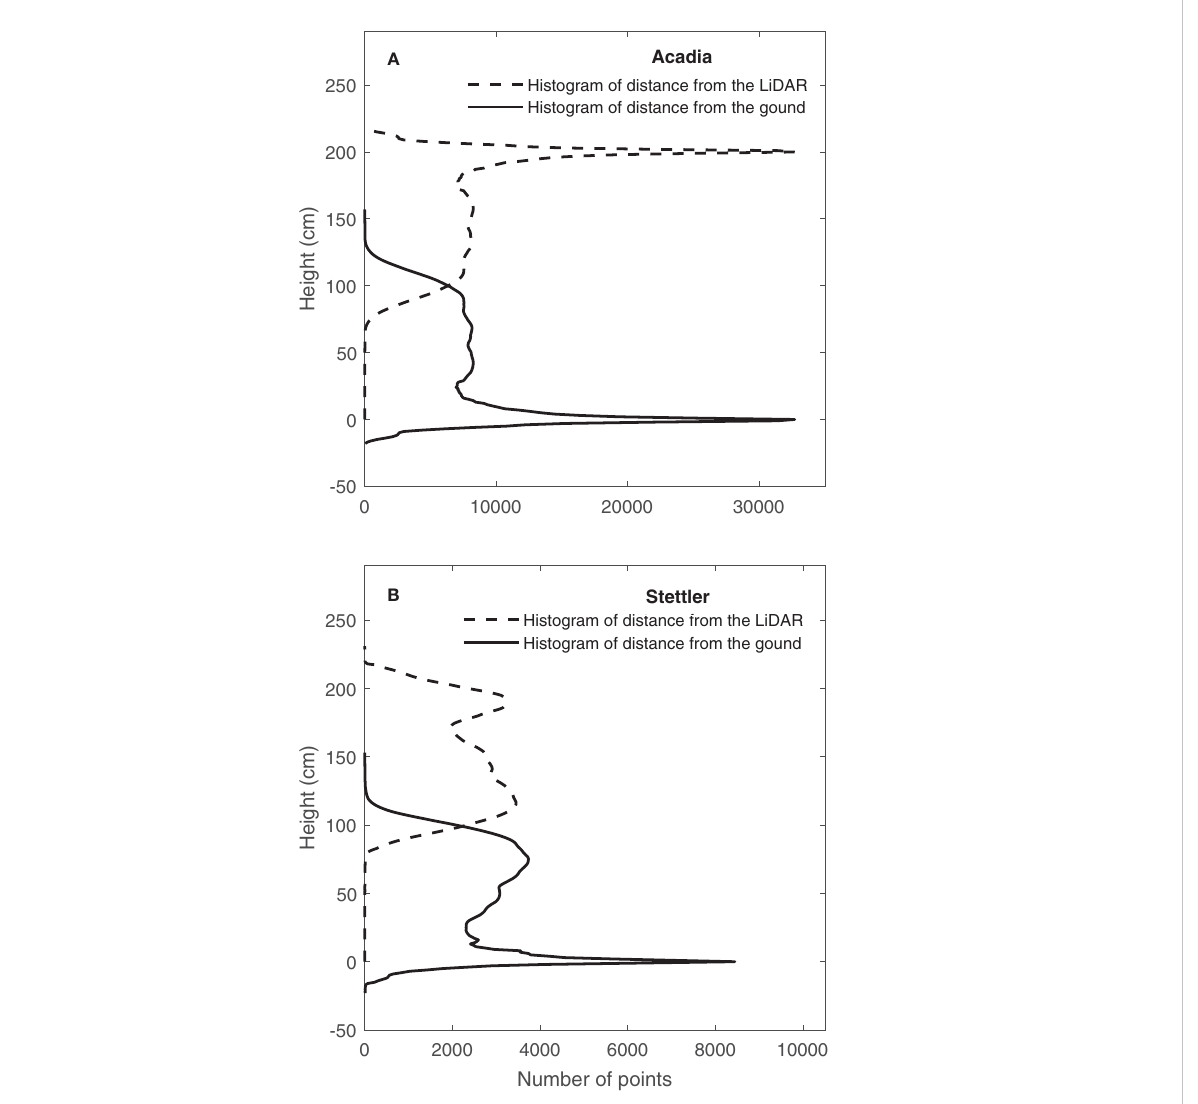
FIGURE 4 Determination of ground elevation from LiDAR data on 15/08/2019. Histogram of distance from the LiDAR and CVP after distance correction and height correction pre-processing were applied for a typical plot (A) (Acadia) when the distance between LiDAR and ground was consistent and (B) (Stettler) when there was variation in payload height with respect to the